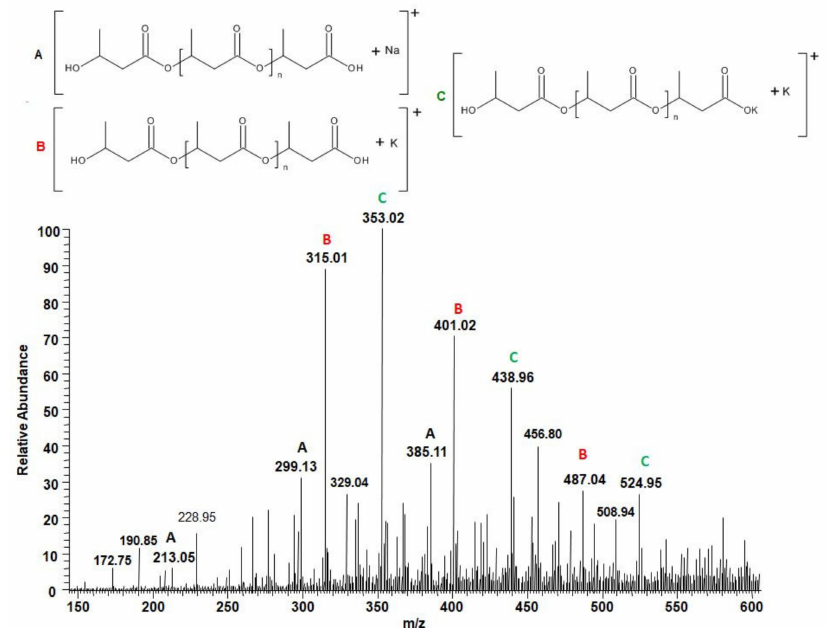
Figure 9. ESI-mass spectrum (positive-ion mode) of the degradation products released from welded PHA 3 to the water after 9 months of